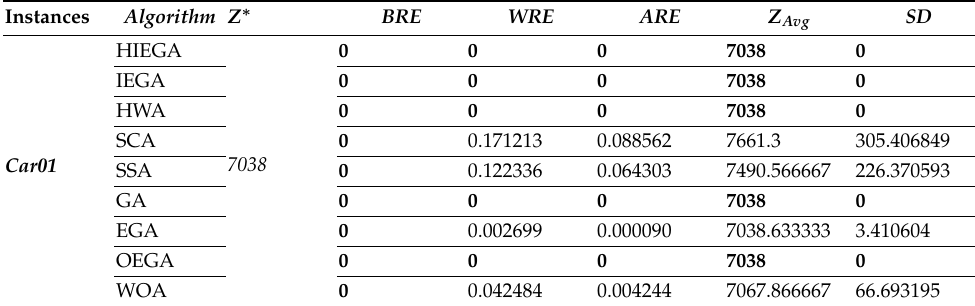
Table 3. Outcomes of different performance metrics on the Car instances